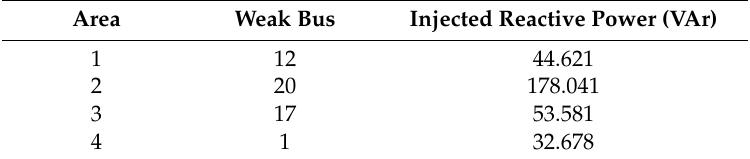
Table 5. Sensitivity indices for all buses’ reactive power injections from renewable energy sources.